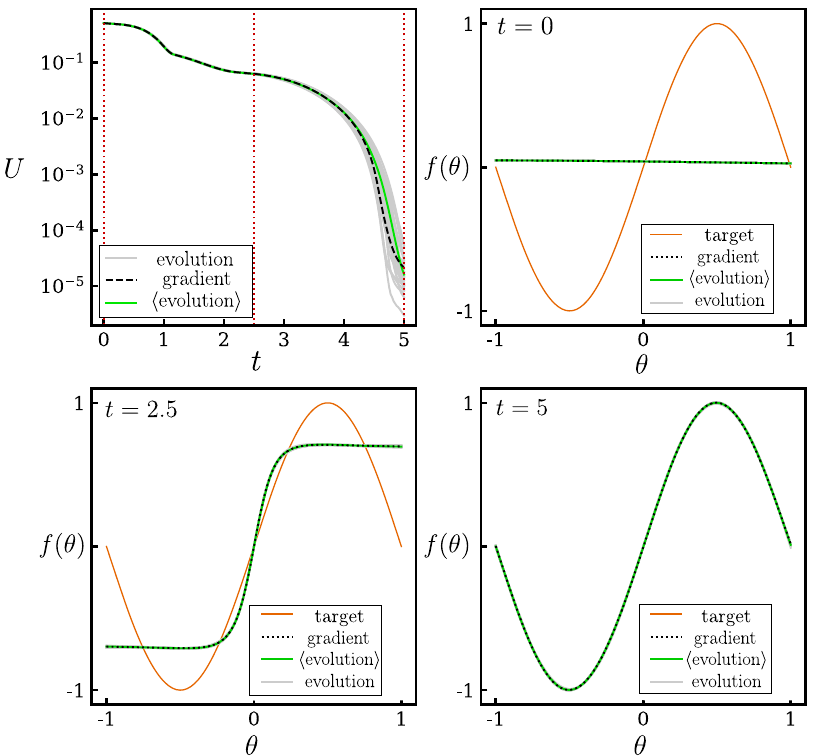
Fig. 5 Illustration of the learning dynamics. Loss versus time and comparison of the target function f 0 ð θ Þ ¼ sin ð πθ Þ and the net function f x ( θ ) at three different training times, for the learning dynamics of Fig. 3 ( λ = 1/10 for the neuroevolution